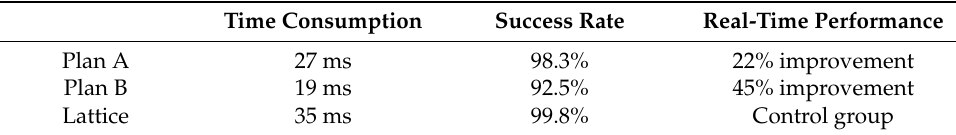
Figure 15. Scenarios with static obstacles: ( a )scenario I; ( b ) scenario II. Table 2. Comparison of two planning plans.